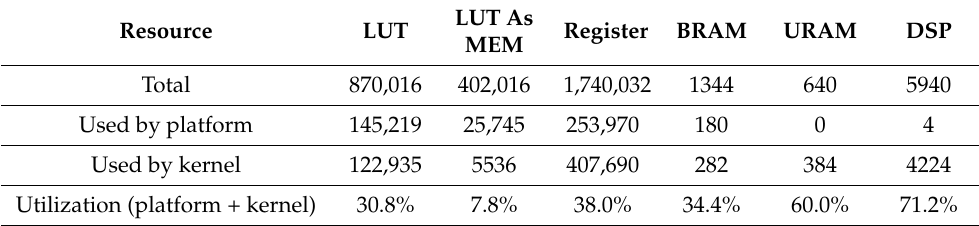
Table 5. Resource usage and